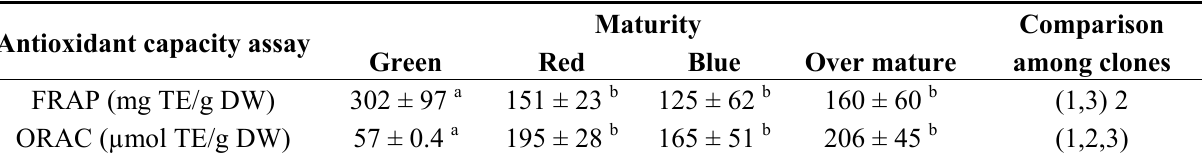
Table 2. Total phenolic content and antioxidant capacity of lowbush blueberries at four maturity